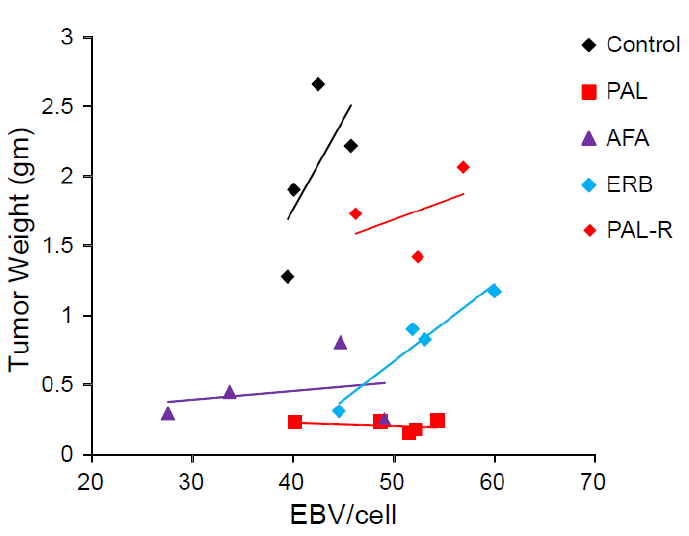
Figure 4. EBV copies per cell related to different treatments of NPC PDX. Abbreviations: PAL, palbociclib; AFA, afatinib; ERB, erbitux; PAL-R, pablociclib resistance.